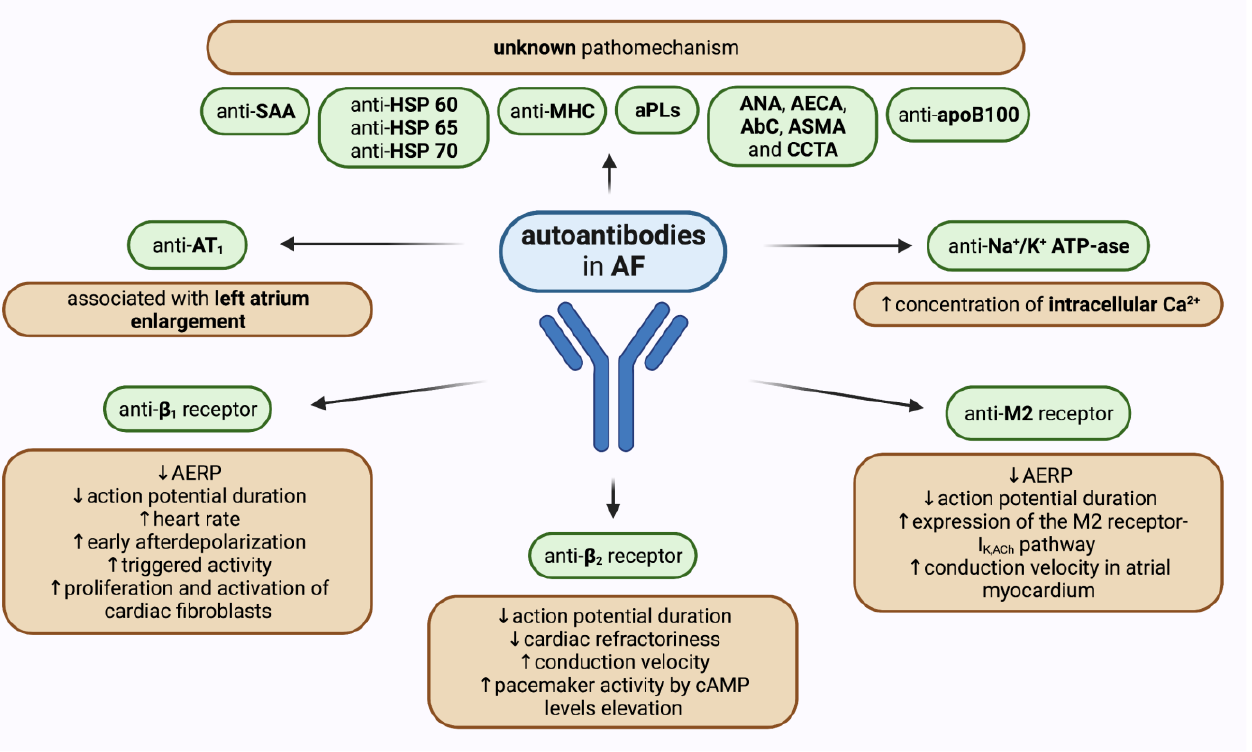
Figure 2. Graphical summary of the role of different autoantibodies in atrial fibrillation with a prob- able pathomechanism of action if known. ↑ —increased, ↓ —decreased, AbC—anti-cardiomyocyte antibodies, AECA—anti-endothelial cell antibodies, AERP—atrial effective refractory period